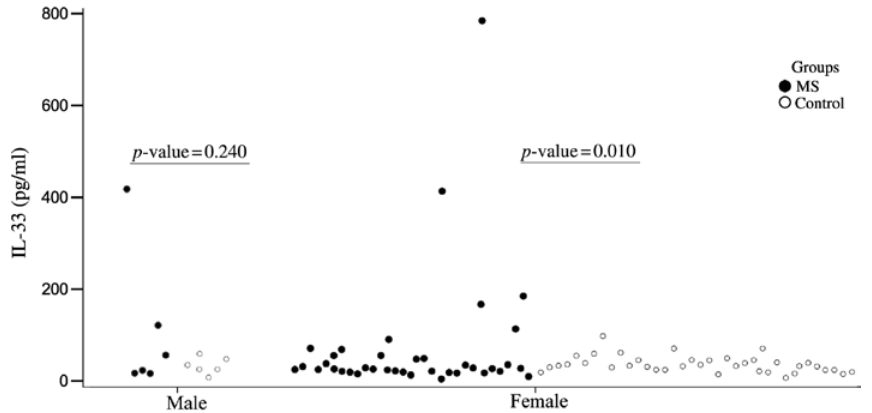
Figure 2: Plasma IL-33 levels in each of the case and control groups based on